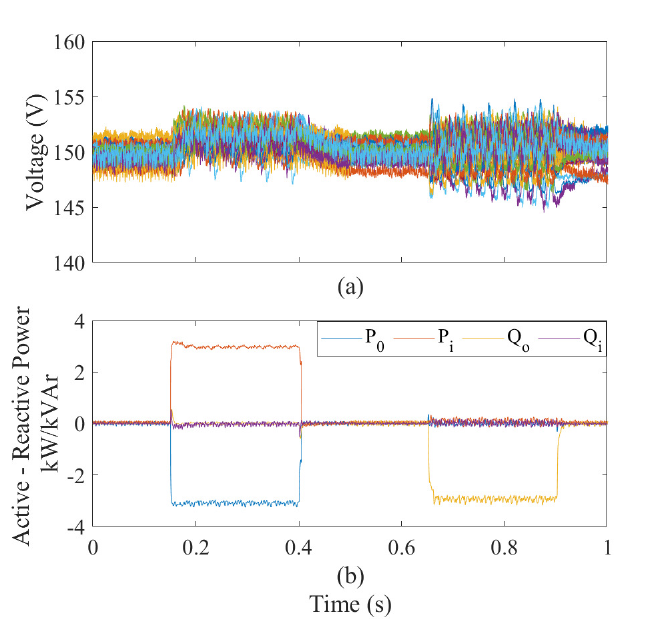
Figure 16. Experimental results for changes in the input-output power